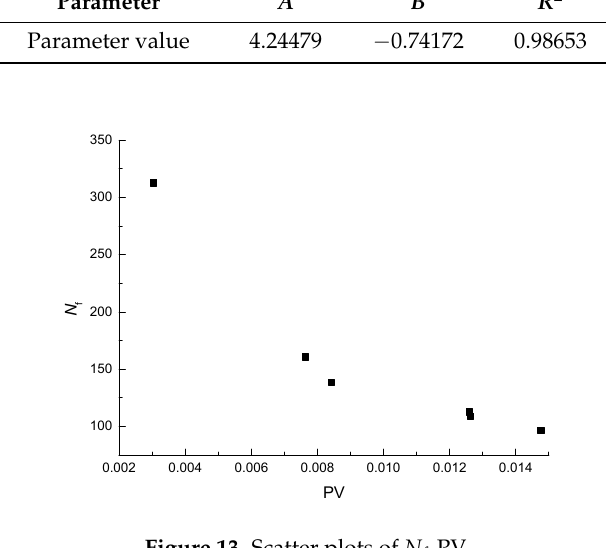
Figure 13. Scatter plots of N f -PV. Table 8. Contrast results of fatigue life.